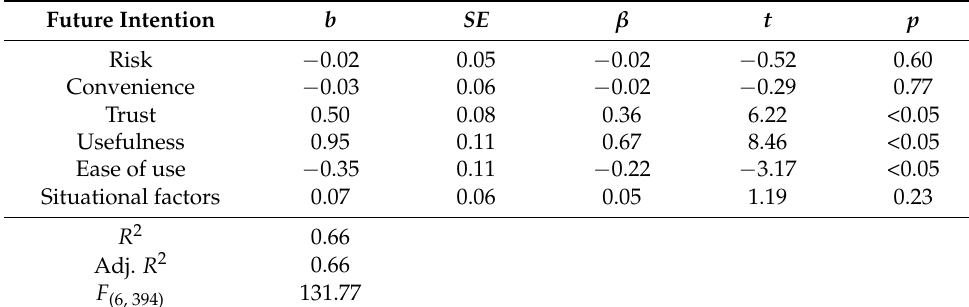
Table 4. Multiple Regression